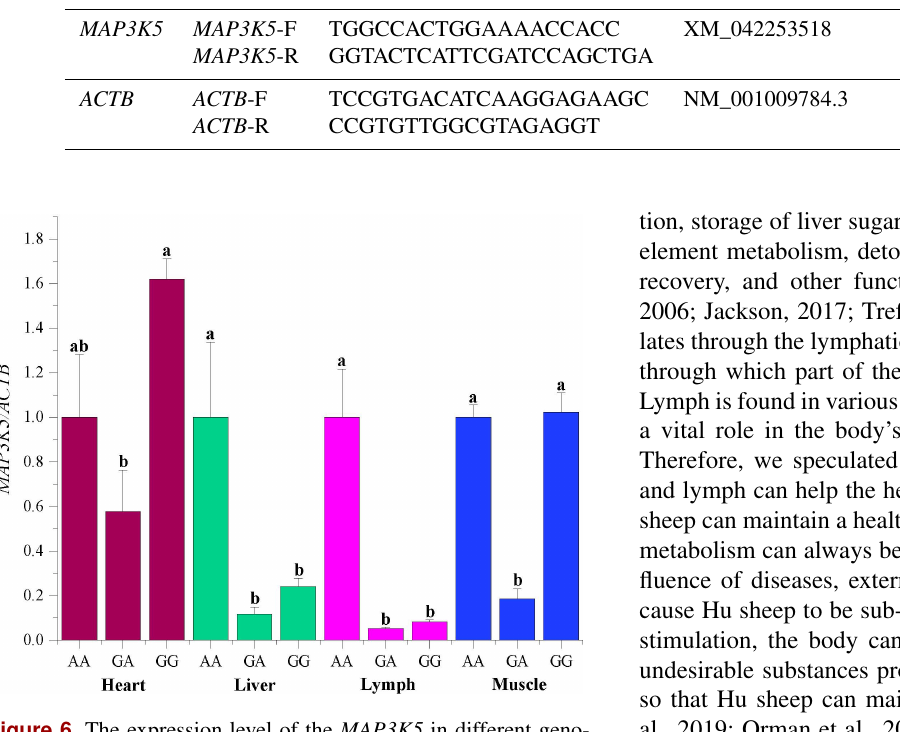
Figure 6. The expression level of the MAP3K5 in different geno- types of Hu sheep. AA, GA, and GG represent Hu sheep of the AA, GA, and GG genotypes, respectively. Different lowercase letters in- dicate significant differences ( P < 0 .